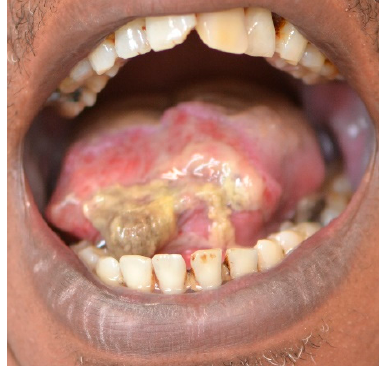
Figure 3. The injury site one week post-trauma.